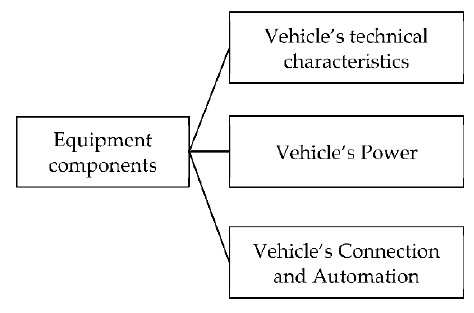
Figure 5. Material components.